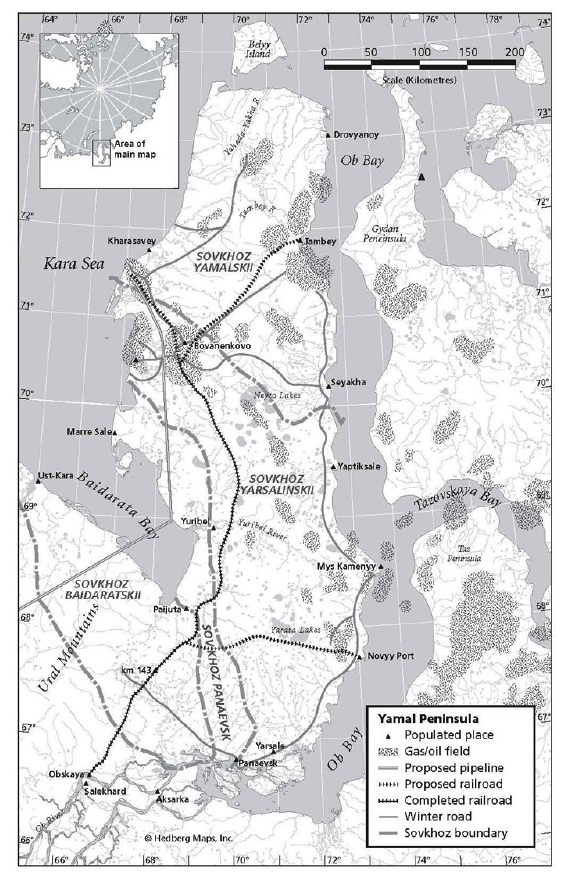
Fig. 3 . Hydrocarbon fields, infrastructure and collective reindeer management (sovkhoz) territories on Yamal Peninsula, West